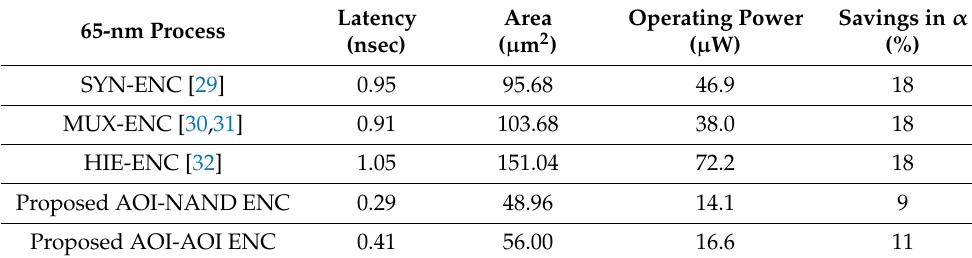
Table 1. Latency, area, power, and savings in switching activity ( α